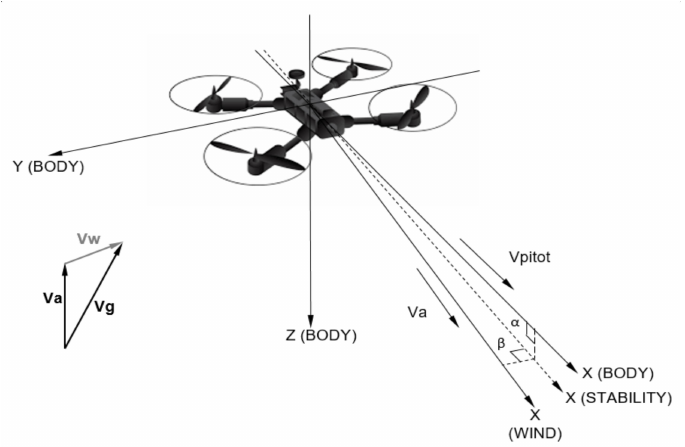
Figure 1. Airspeed definition and wind